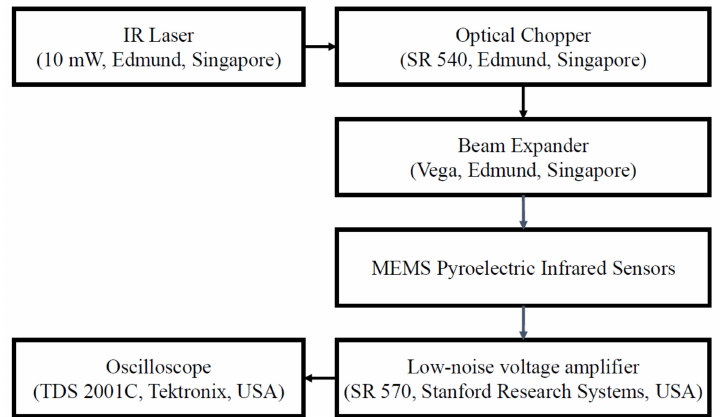
Figure 6. Experimental setup for evaluating voltage response of ZnO pyroelectric